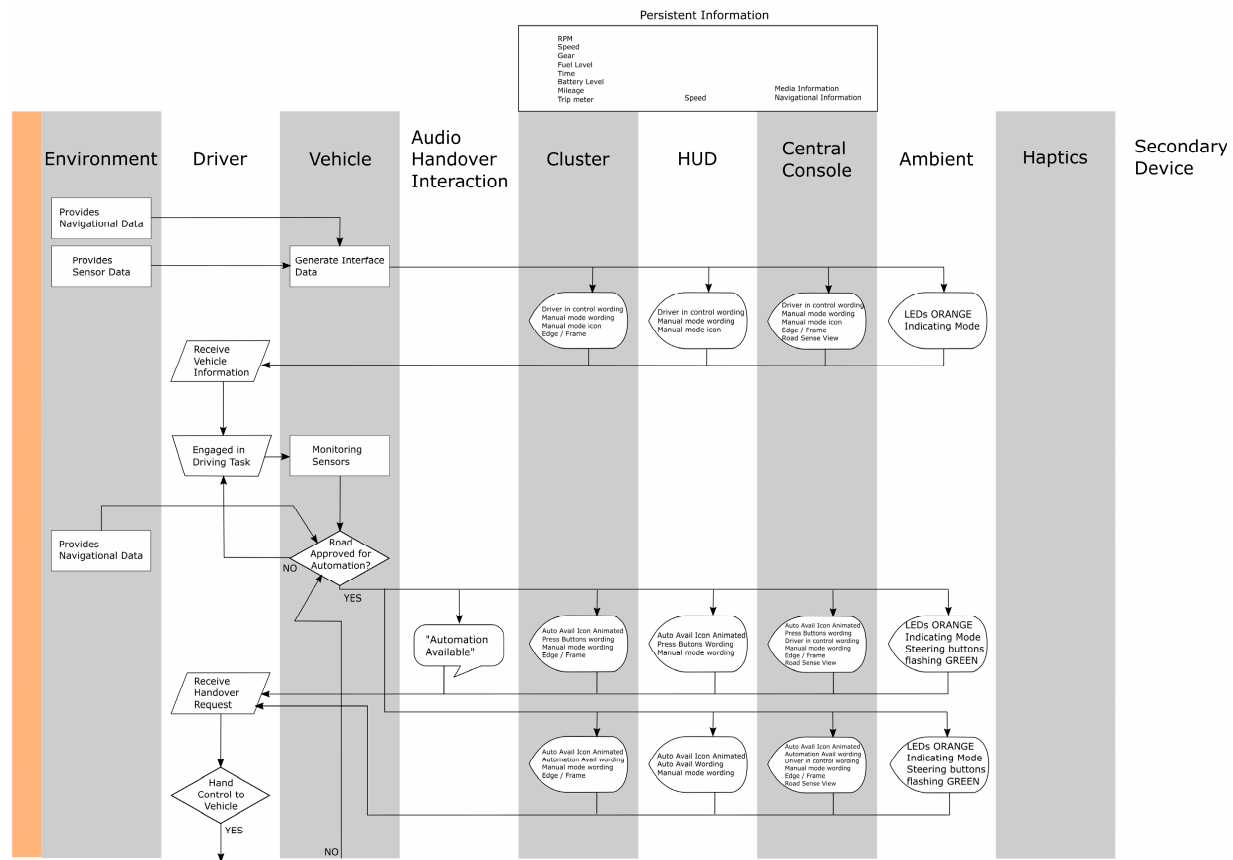
Figure 1. Human driver in control when automation becomes